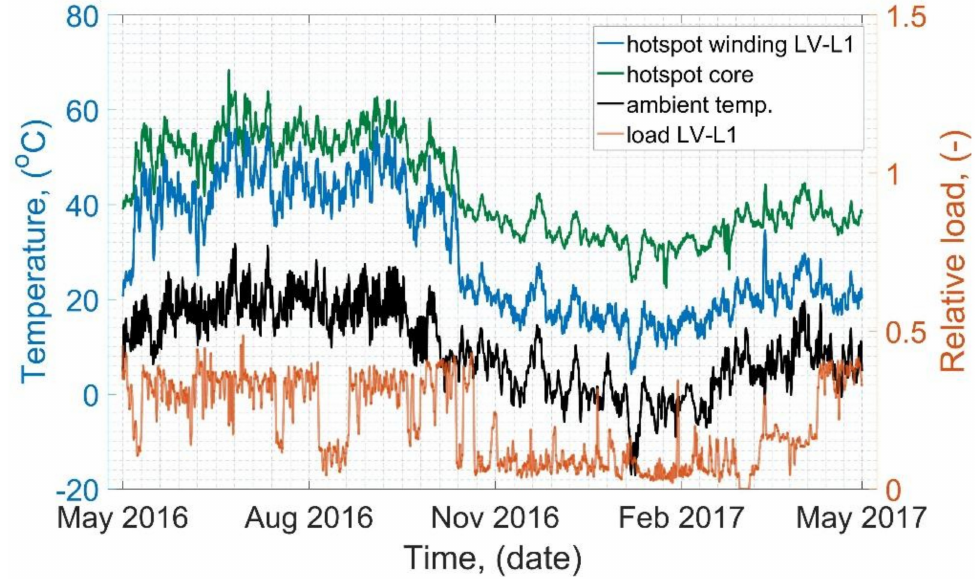
Figure 4. Exemplary temperature and load variability of the